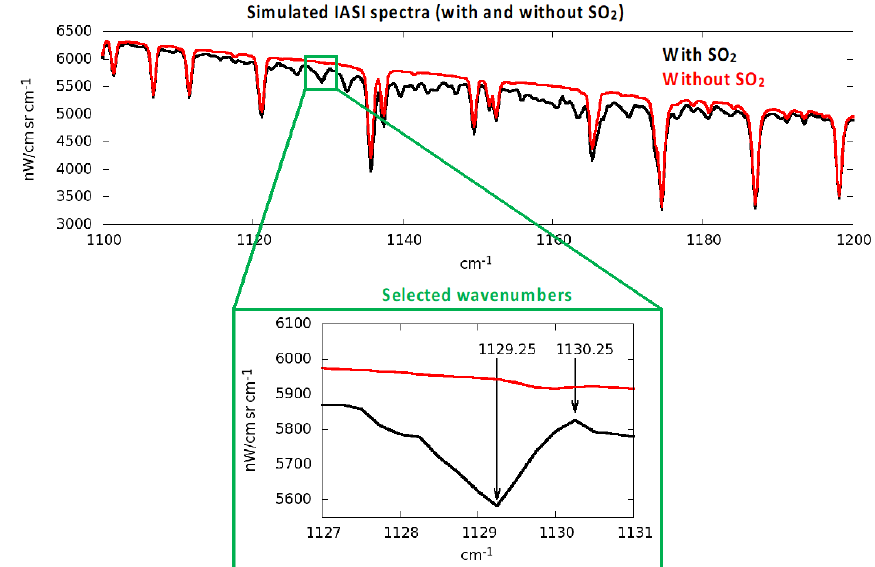
Figure 1. Simulated IASI spectra with (black) and without (red) SO 2 and a zoom of the SO 2 absorption line used to define the D SO parameter of Eq.